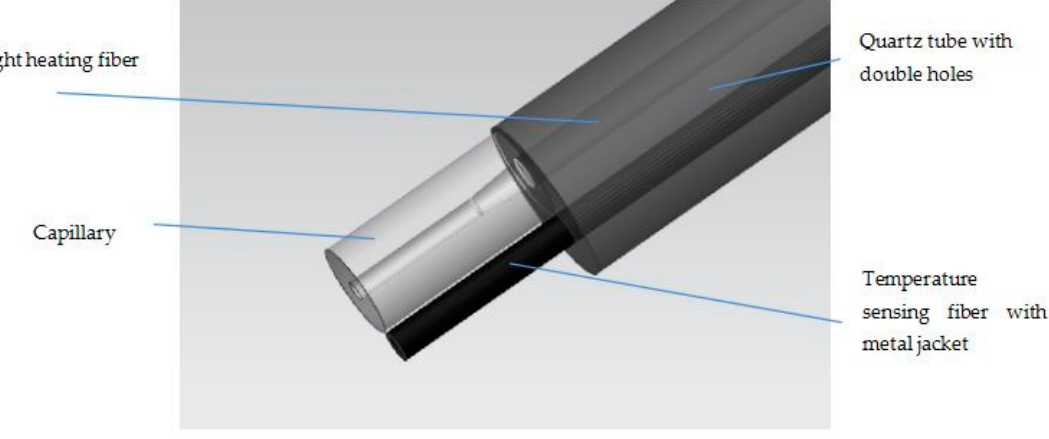
Figure 3. Self heating and temperature sensing head.